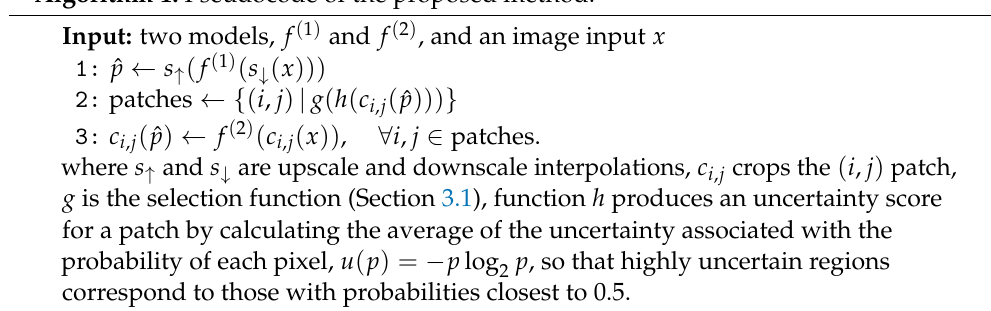
Algorithm 1: Pseudocode of the proposed